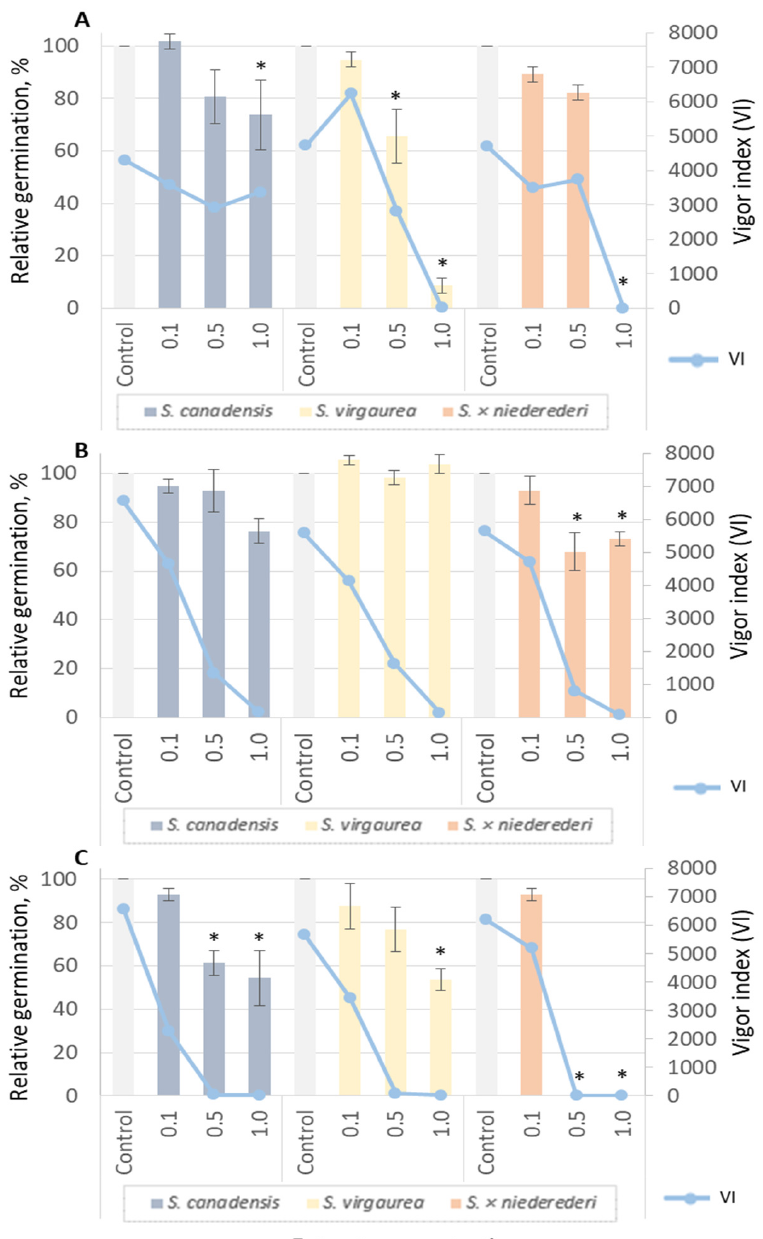
Figure 3. Effect of aqueous extracts from S. canadensis , S. virgaurea and S. × niederederi roots ( A ), leaves ( B ) and inflorescences ( C ) on relative germination (RG) and vigor index (VI) of garden pepper cress seeds (G test, p < 0.05). Data are presented as the mean of treatments (n = 60) ± SD (bars); asterisk (*) indicates a statistically significant difference compared to the control.